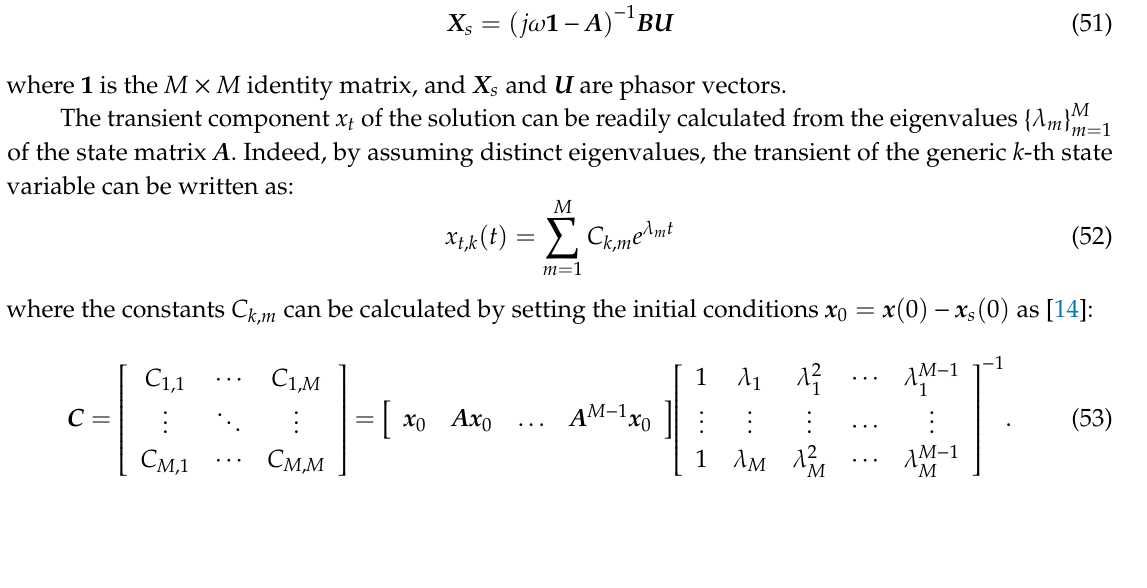
Figure 9. Connection of modal circuits in the time domain. Line switching of phases b and c results in ( a ) coupled α and 0 circuits through an ideal transformer with ratio k 2 = − 1/ circuit β